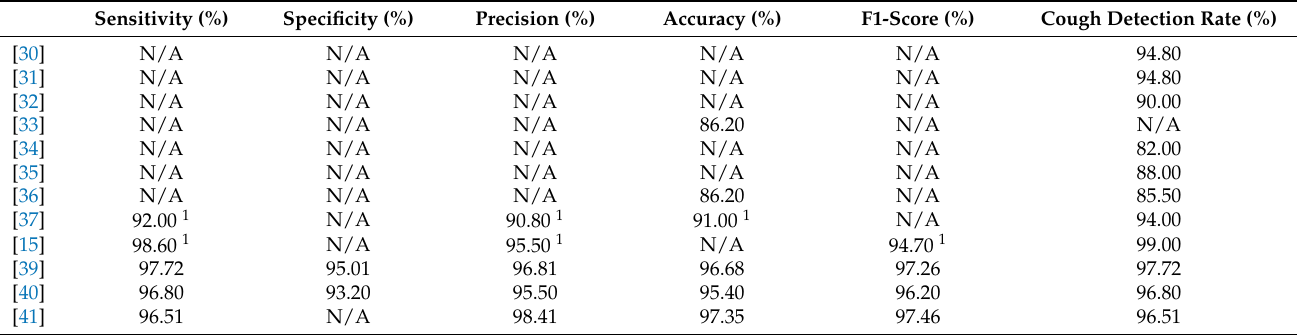
Table 6. PLF performance measures for swine